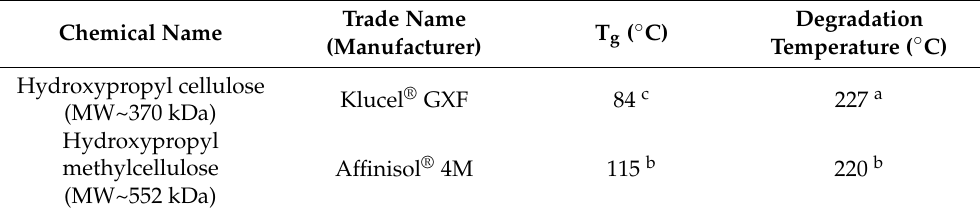
Table 1. Polymers used for melt granulation of metformin